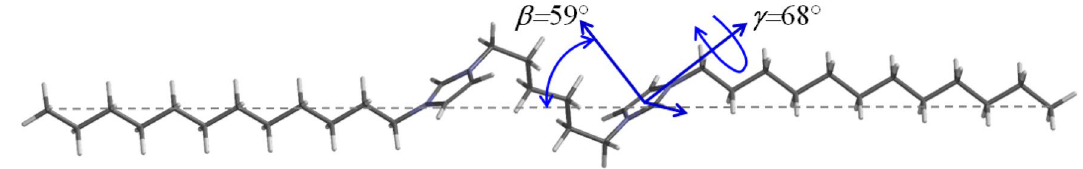
Figure 5. Schematic illustration of the imidazolium ring alignment in the DIL. This DFT-optimized structure is consistent with the experimental order parameters found in the imidazolium ring and for C1 methylenes. Other possible lower energy structures with the ring planes perpendicular to the all-trans side-chain axis or parallel to the side-chain backbone plane 26,27 are not consistent with the experimental